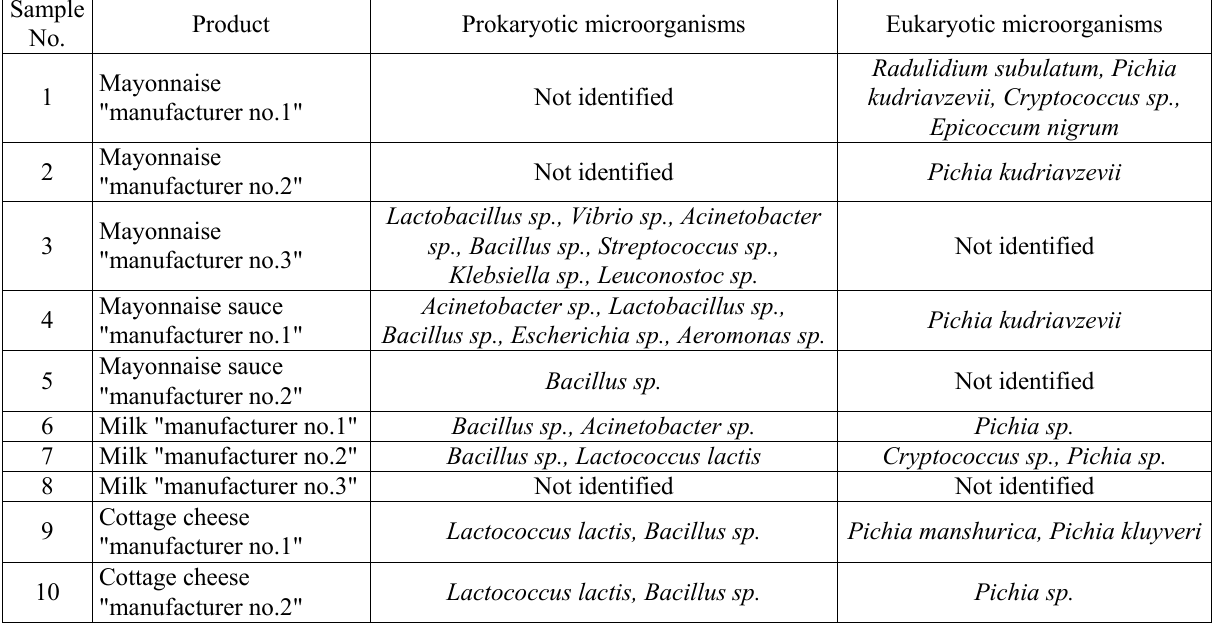
Table 7. List of microorganisms detected by high-performance sequencing